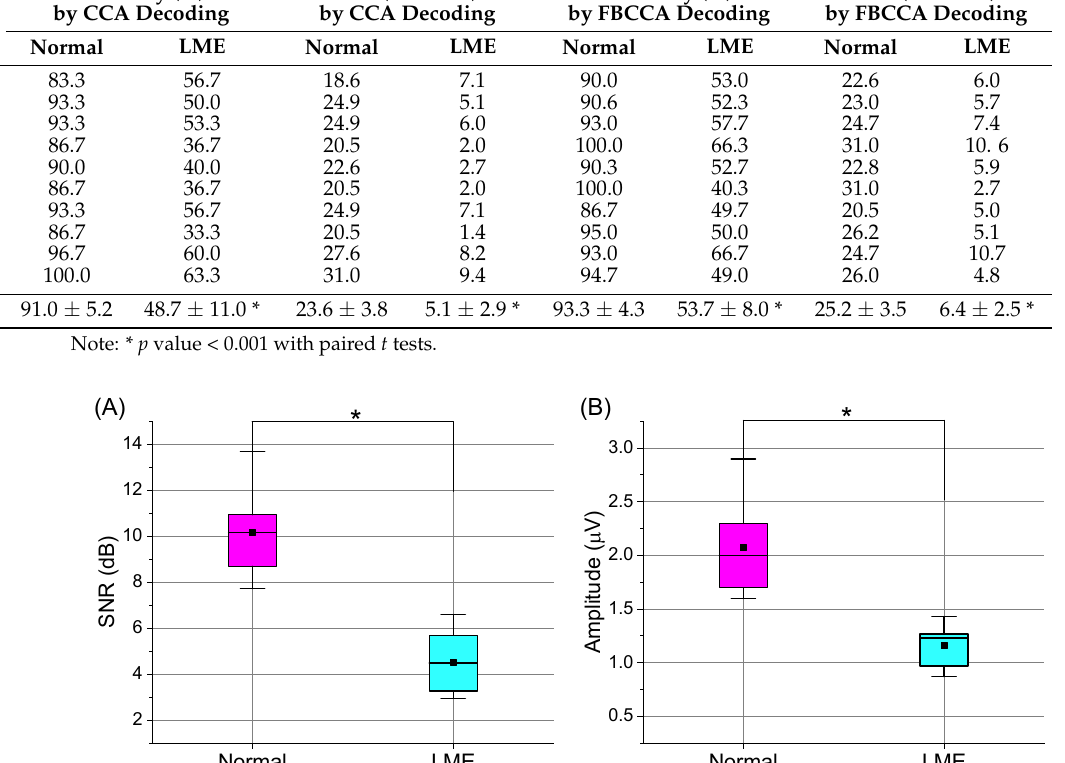
(G) The SSVEP Signals with the Frequency of 11.0 Hz